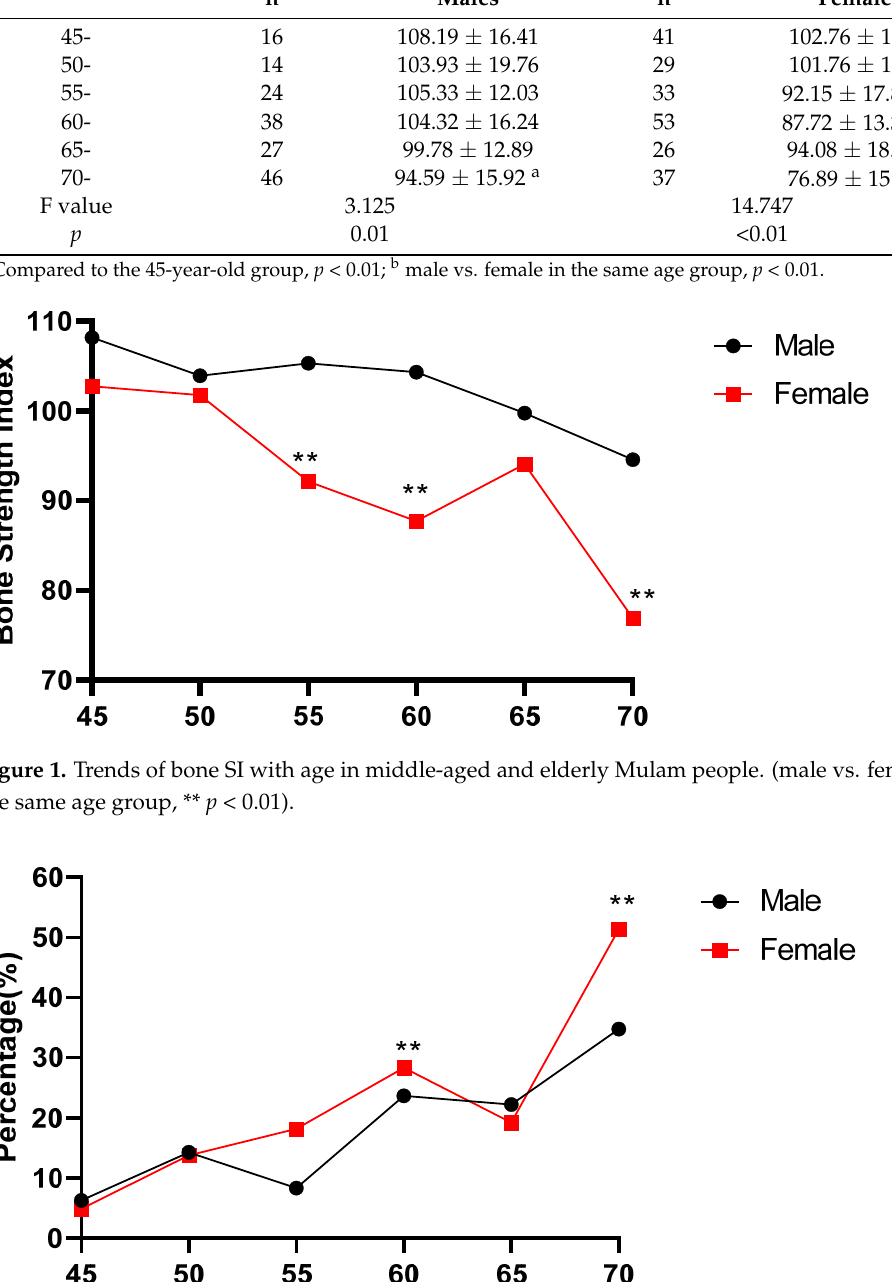
(Table 2). Set control group = 0 and case group = 1. Taking SI as the dependent variable,